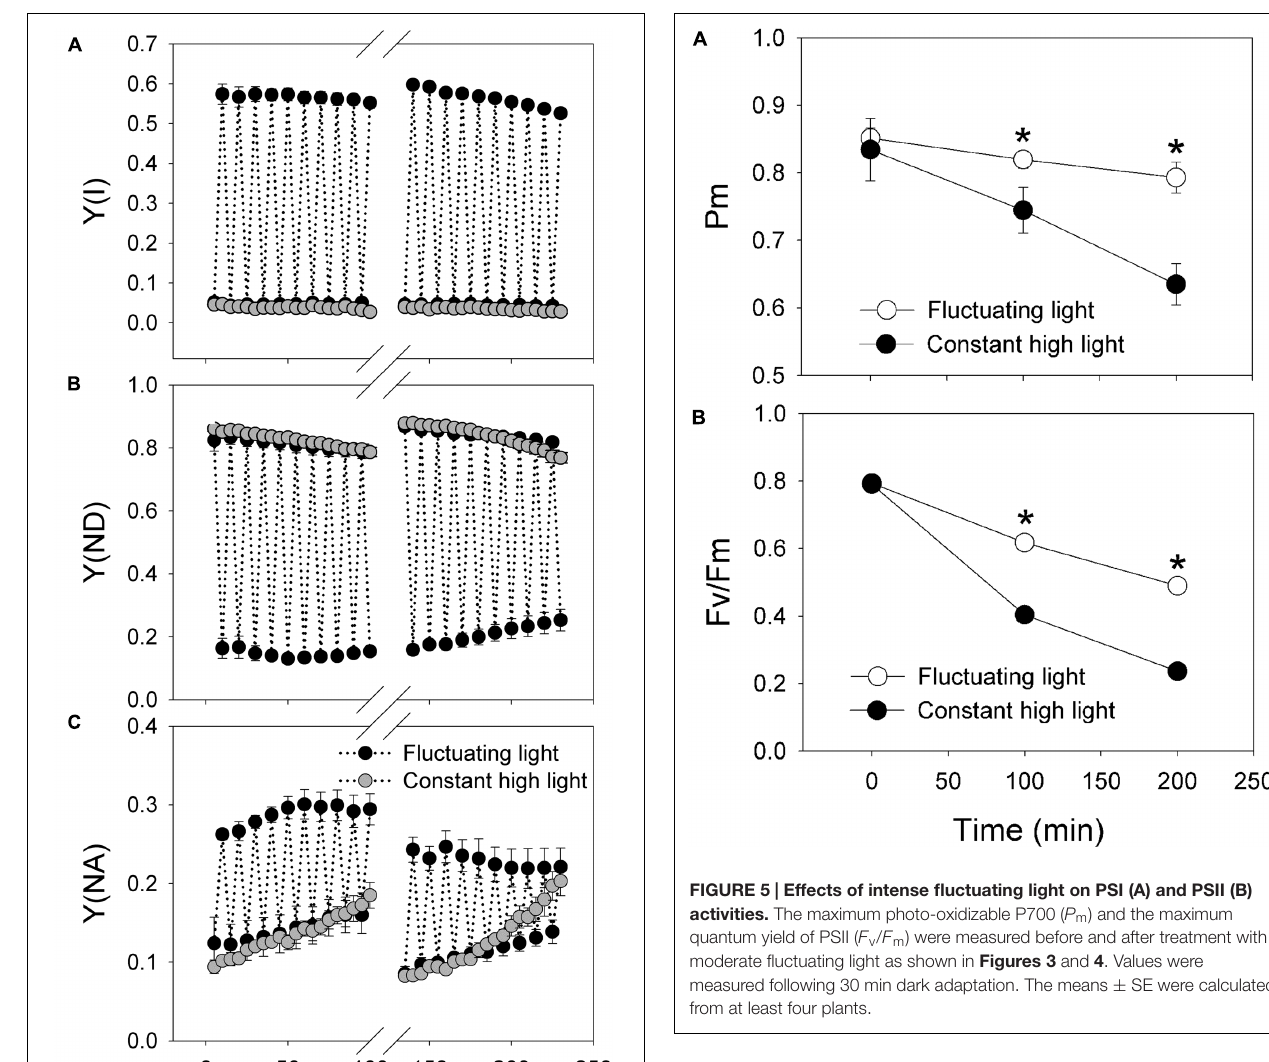
1294 µ mol photons m − 2 s − 1 every 2 min) for 60 min, F v / F m